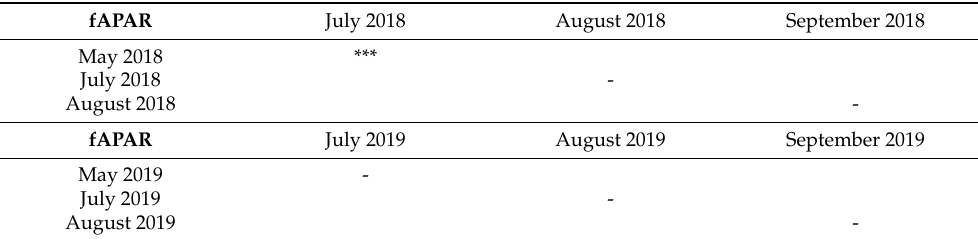
Table A2. Kruskal–Wallis test results for fAPAR between adjacent image acquisitions dates. The presence of *** denotes that the null hypothesis was rejected and that the samples are significantly different at p = 0.05 level.